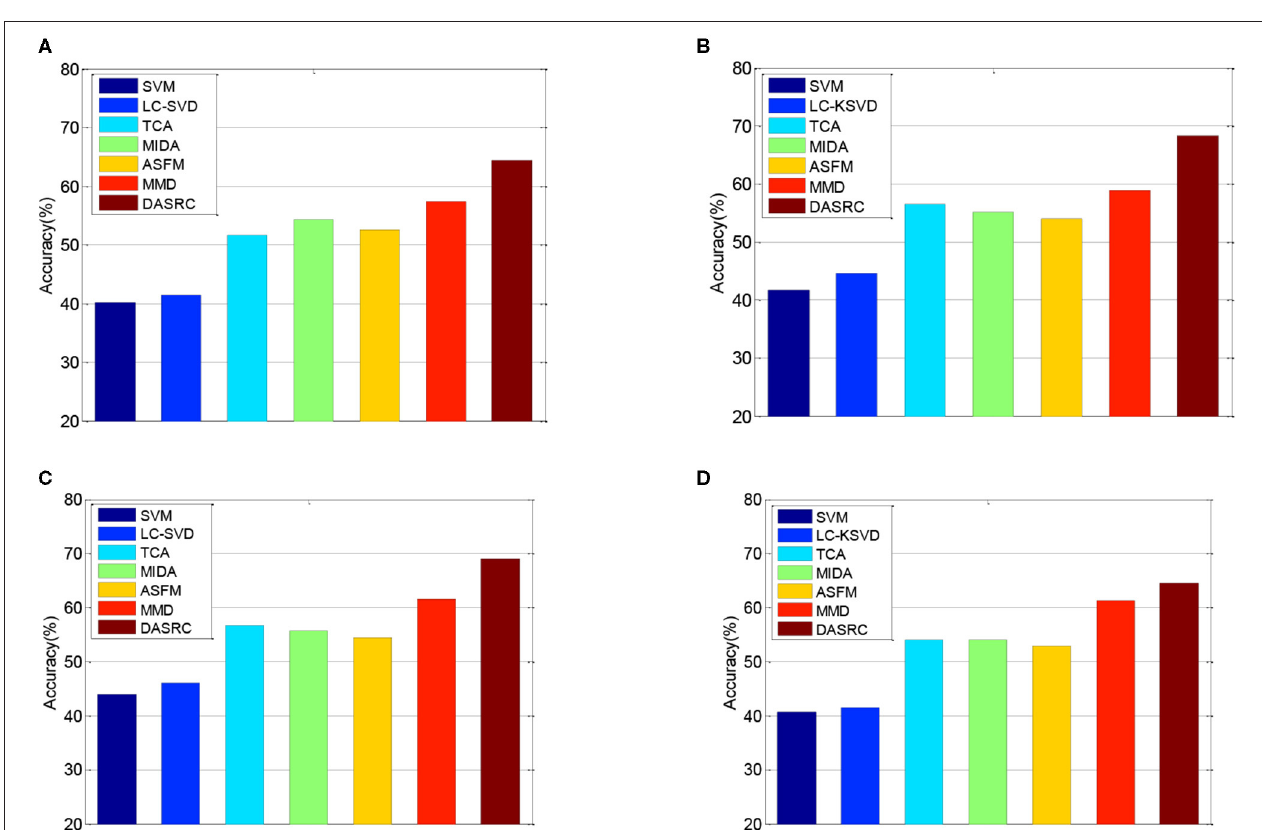
FIGURE 4 | Cross-subject accuracy on DEAP dataset with different features, (A) PSD, (B) FD, (C) DE, (D) MAV.